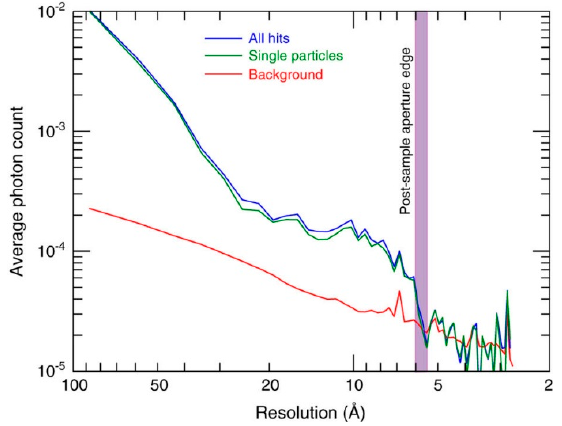
Figure 8. Radial average of signals using hard X-rays . Elevated photon counts from the sample are visible up to an angle commensurate with 5.9 Å resolution, this being the resolution limit set by the angular acceptance of a post-sample aperture. (reproduced with permission from [180]. Copyright Springer Nature, 2016).